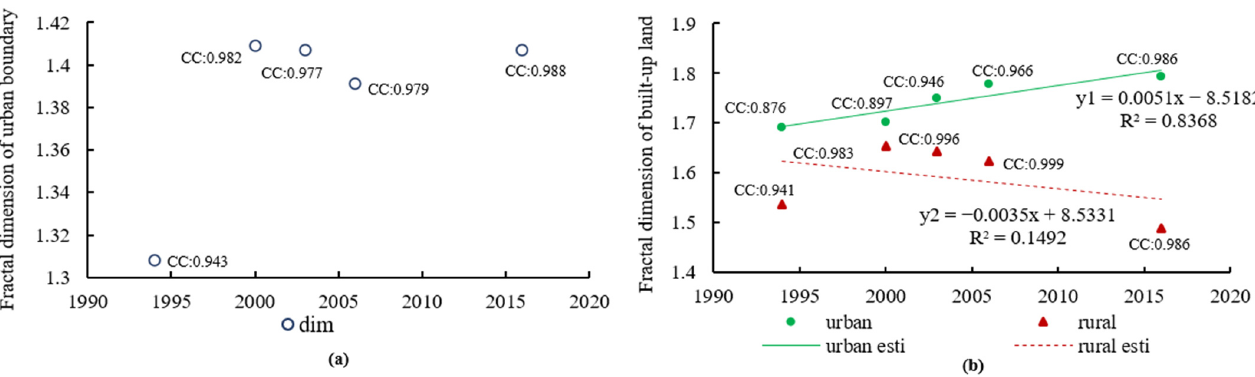
Figure 11. ( a ) and ( b ) represent the fractal dimensions of boundary and built-up land respectively, where CC means the correlation coefficient of log(r) and log(N).